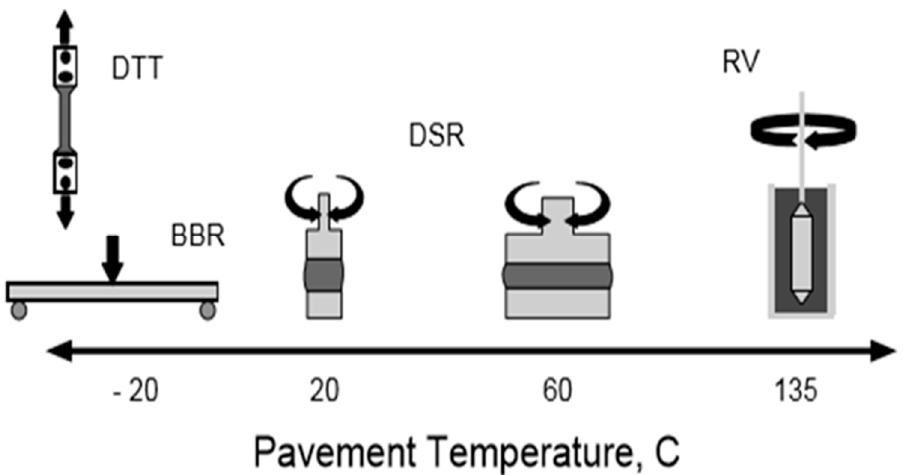
Figure 3. The schematics of creep stiffness (S) and creep rate (m)